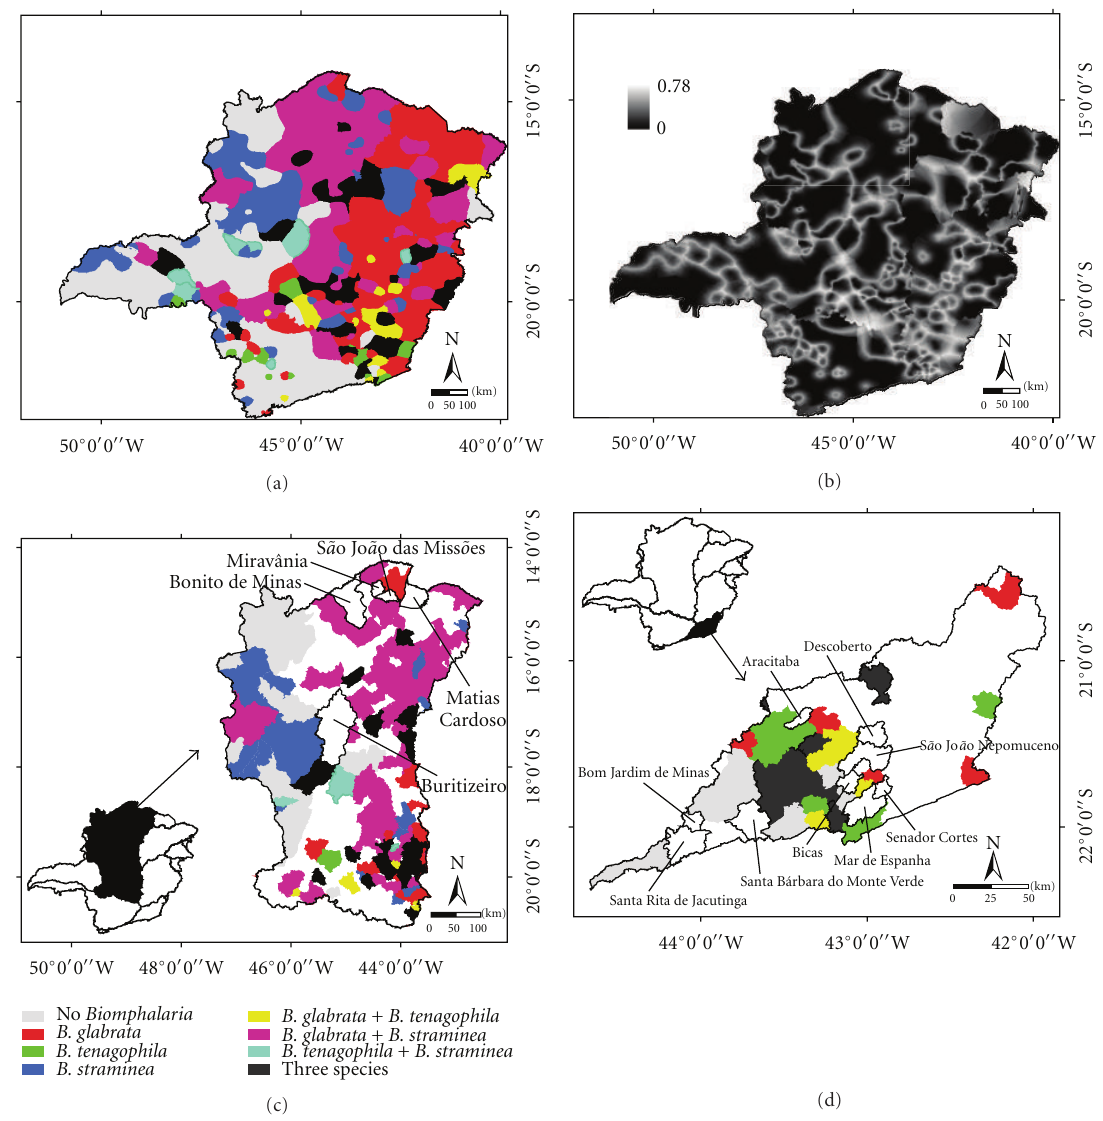
Figure 2: (a) Map of the estimated species distribution, (b) map of the uncertainties, (c) historical Biomphalaria species in S˜ao Francisco River Basin, and in (d) Para´ıba do Sul River Basin. (Source: [18,